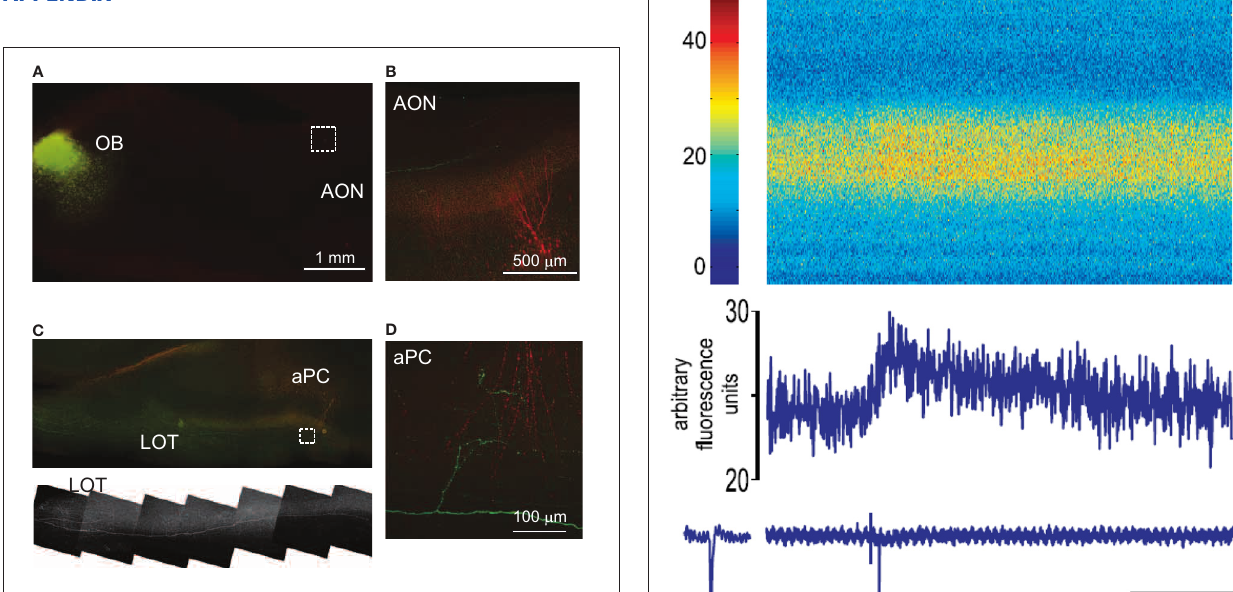
FIGURE A1 | Mitral cell projection to the PC. Direct injection of AAV into the OB induced expression of ChR2-EYFP mostly in periglomelular cells, granule cells, and glial cells at the injection site, with almost no mitral cell labeling (A) . Only a few fibers can be recognized passing through the LOT (B,C) , and some branched fibers from the LOT innervate layer 1a in the aPC (D) .